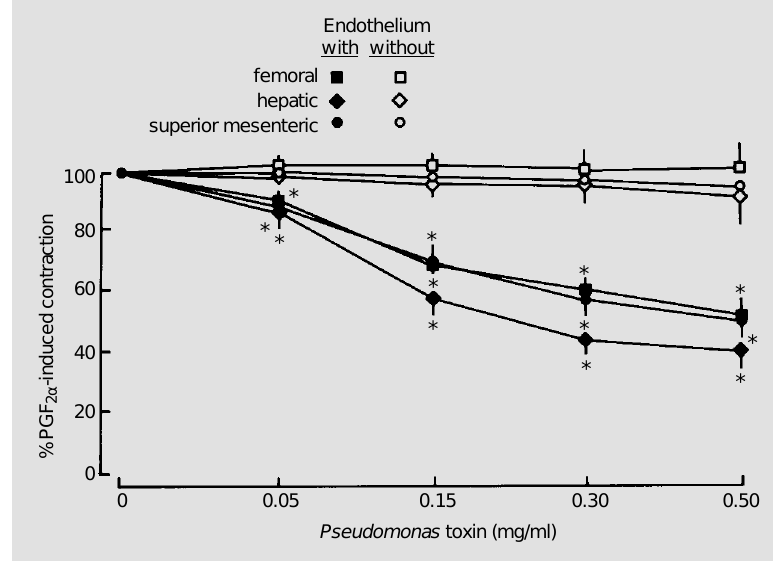
Figure 3 - Concentration-response relationship for Pseudomonas aeruginosa lipopolysac- charide of canine femoral, hepatic, and superior mesenteric arteries (N = 6 per group). Segments were contracted with 2 µM prostaglandin F 2 a (PGF 2 a ) (initial tension) and exposed to increasing concentrations of endotoxin (0.05-0.50 mg/ml). Results are reported as means ± SEM. *P<0.05 compared to the initial tension (Student t -test).